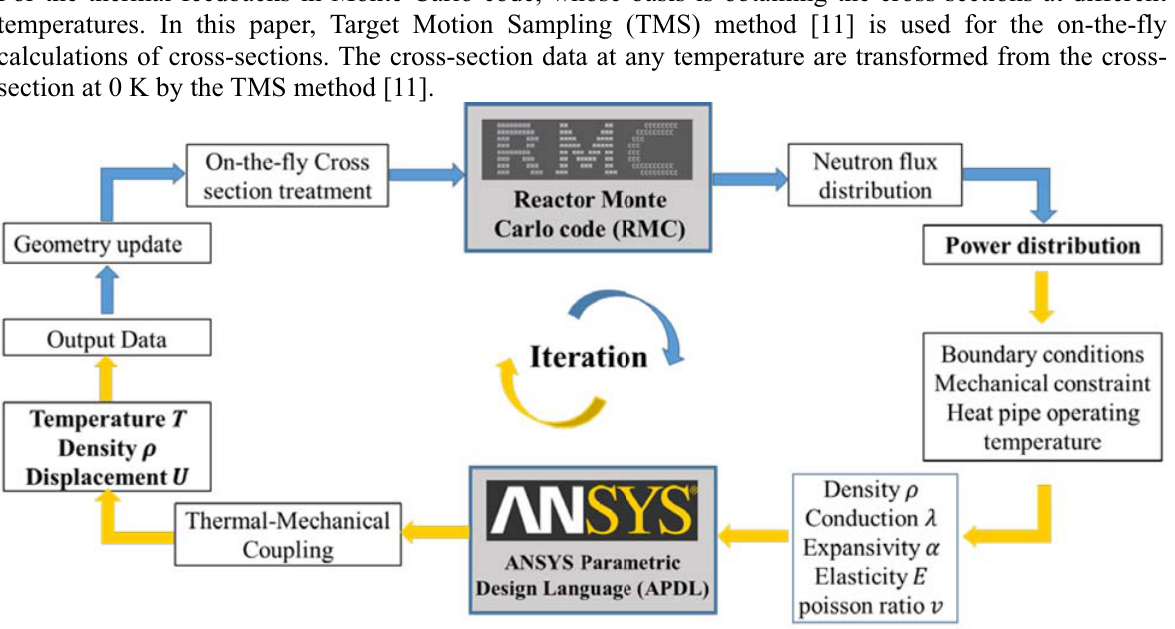
Figure 2. Coupling framework of